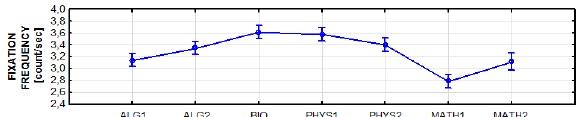
Figure 8. The fixation frequency - a distribution of the mean values for the particular tasks.